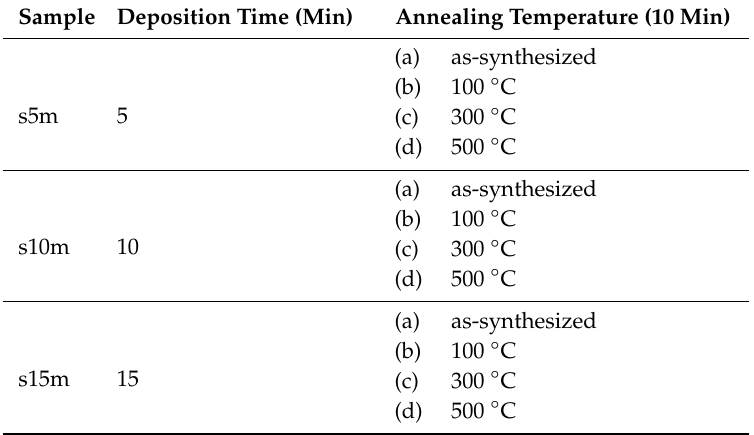
Table 1. Deposition time and annealing temperature for the samples.